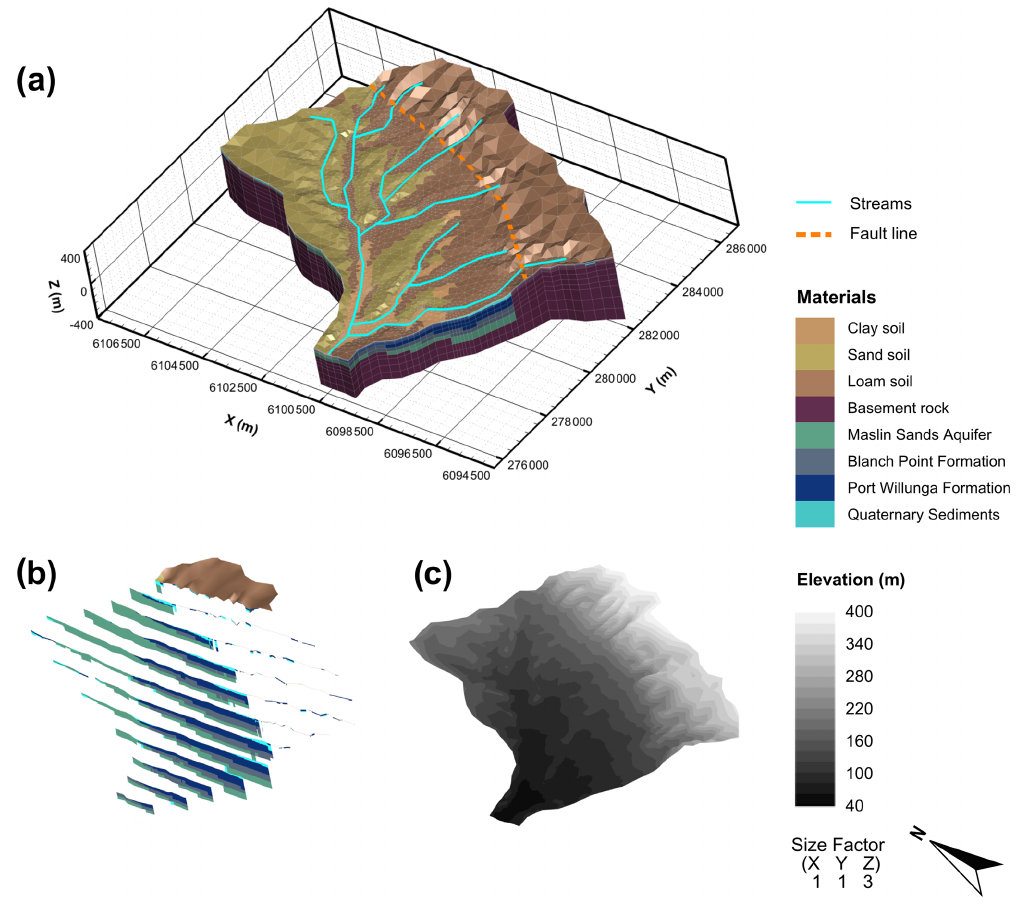
Figure 4. (a) A 3D representation of the Pedler catchment showing the mesh discretisation and the spatial distribution of shallow soil types. (b) Slices showing the distribution and thickness of the hydrogeological layers. (c) Digital elevation model showing the surface topography. Approximated location of the discretised stream network and the fault line are superimposed for illustration